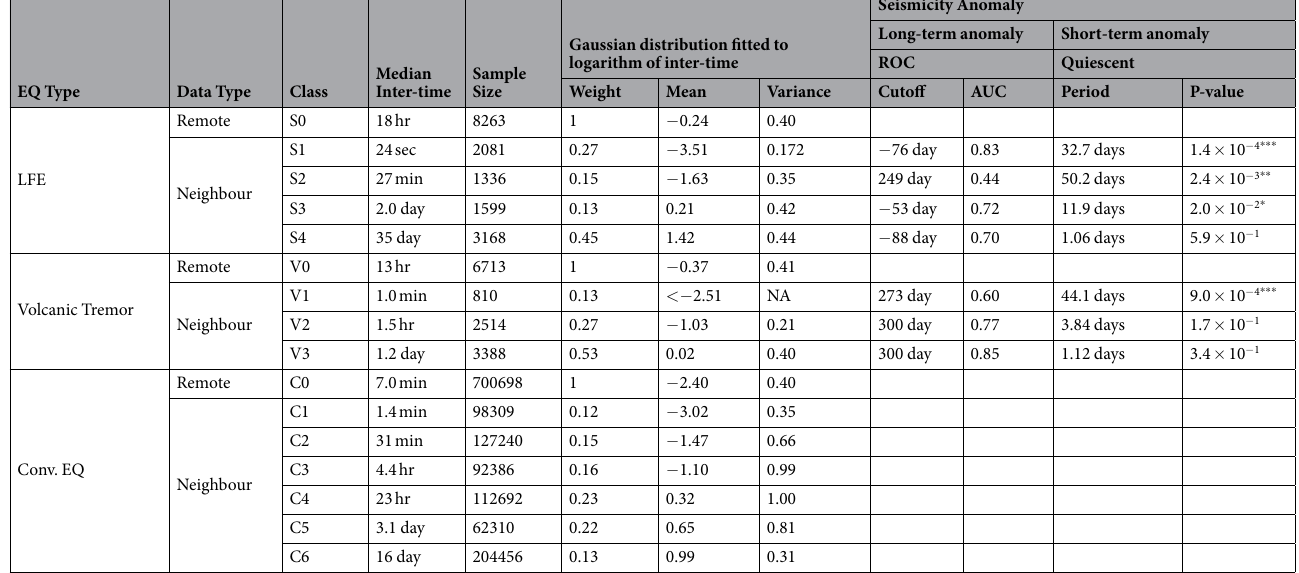
Table 1. Characteristic of each class of earthquake. Weight, mean, and variances are based on Gaussian mixtures for logarithms (base 10) of inter-time. ROC cutoff is the optimal value of cutoff to split inter-times into two segments for ROC analysis. Quiescent period denotes the period between the origin time of the Tohoku-oki EQ and the time that the last event of corresponding class took place before the Tohoku-oki EQ. P-values were evaluated by fitting a left-truncated exponential distribution (truncated point is one day) to the data before the Tohoku-oki EQ, where the mean value of the distribution was estimated using a robust statistic, median/log2 55 . Asterisks denote level of significance of p-values: *** p < 0.001; ** p < 0.01; * p <